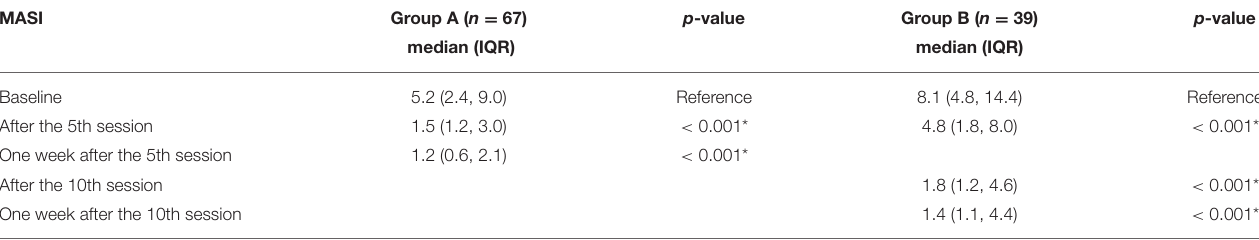
TABLE 3 | Median melasma area and severity index (MASI) changes from baseline.